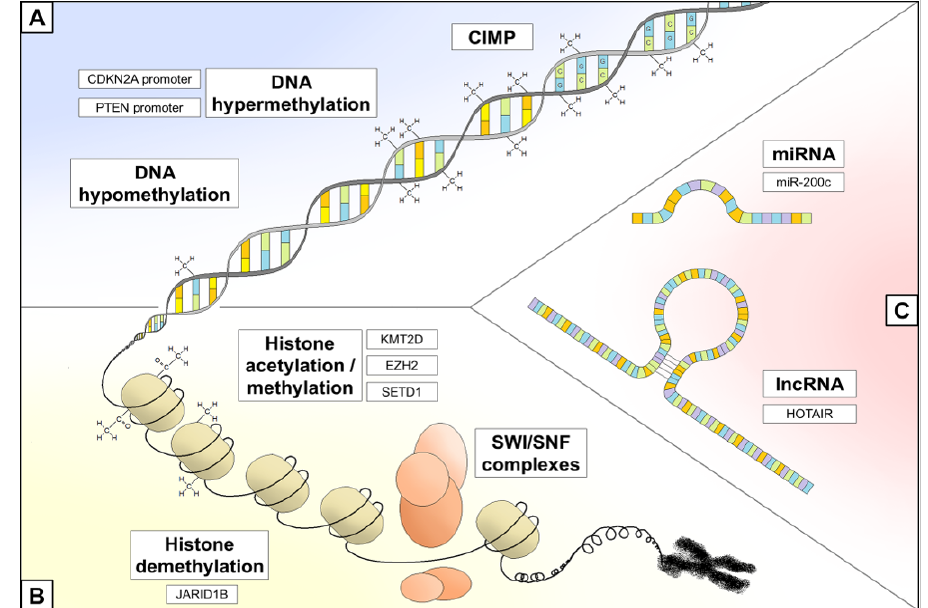
Figure 1. Main epigenetic mechanisms involved in melanoma onset and progression (bold text), with some examples of alterations for each mechanism. ( A ) DNA methylation status; ( B ) chromatin remodeling; ( C ) non-coding RNA. Abbreviations: CIMP, CpG island methylator phenotype; miRNA, microRNA; lncRNA, long non-coding RNA; SWI/SNF, SWItch/sucrose